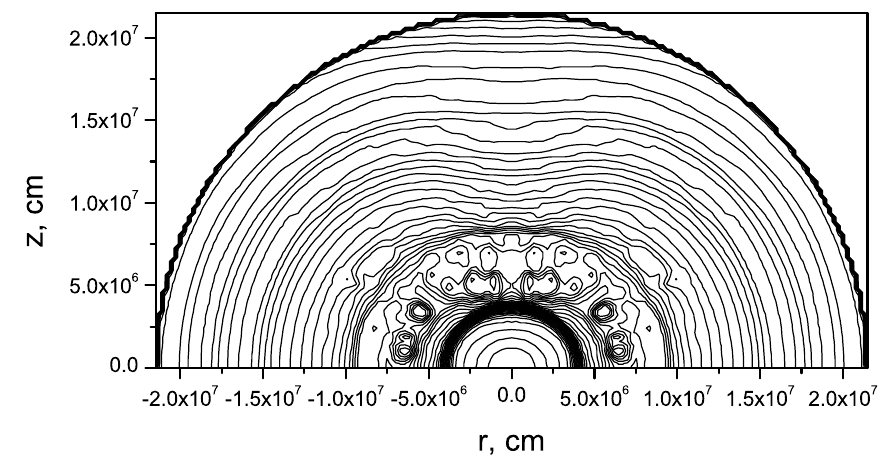
Figure 3. Contours of constant density in the equatorial plane y = 0 ( φ = 0). in the problem of collapse for parameters lg ρ min = 7, lg ρ max = 13, ∆ lg ρ = 0.1 (unit of density g cm − 3 ) demonstrates the development of large-scale